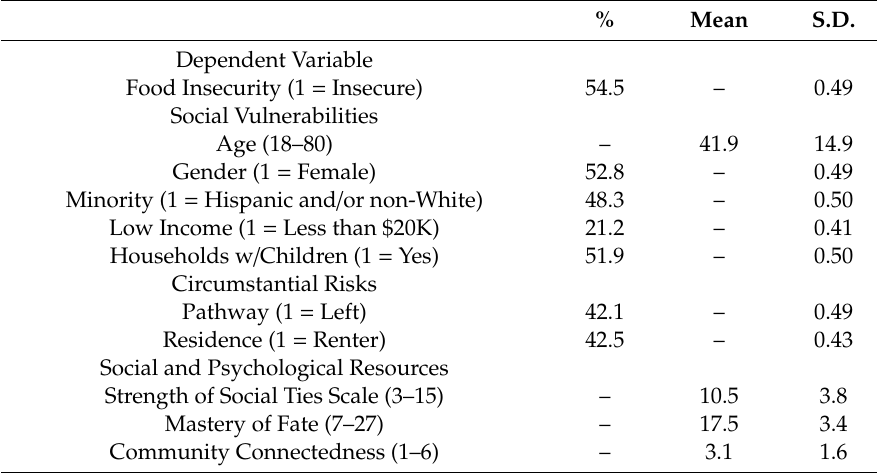
Table 1. Descriptive statistics for model